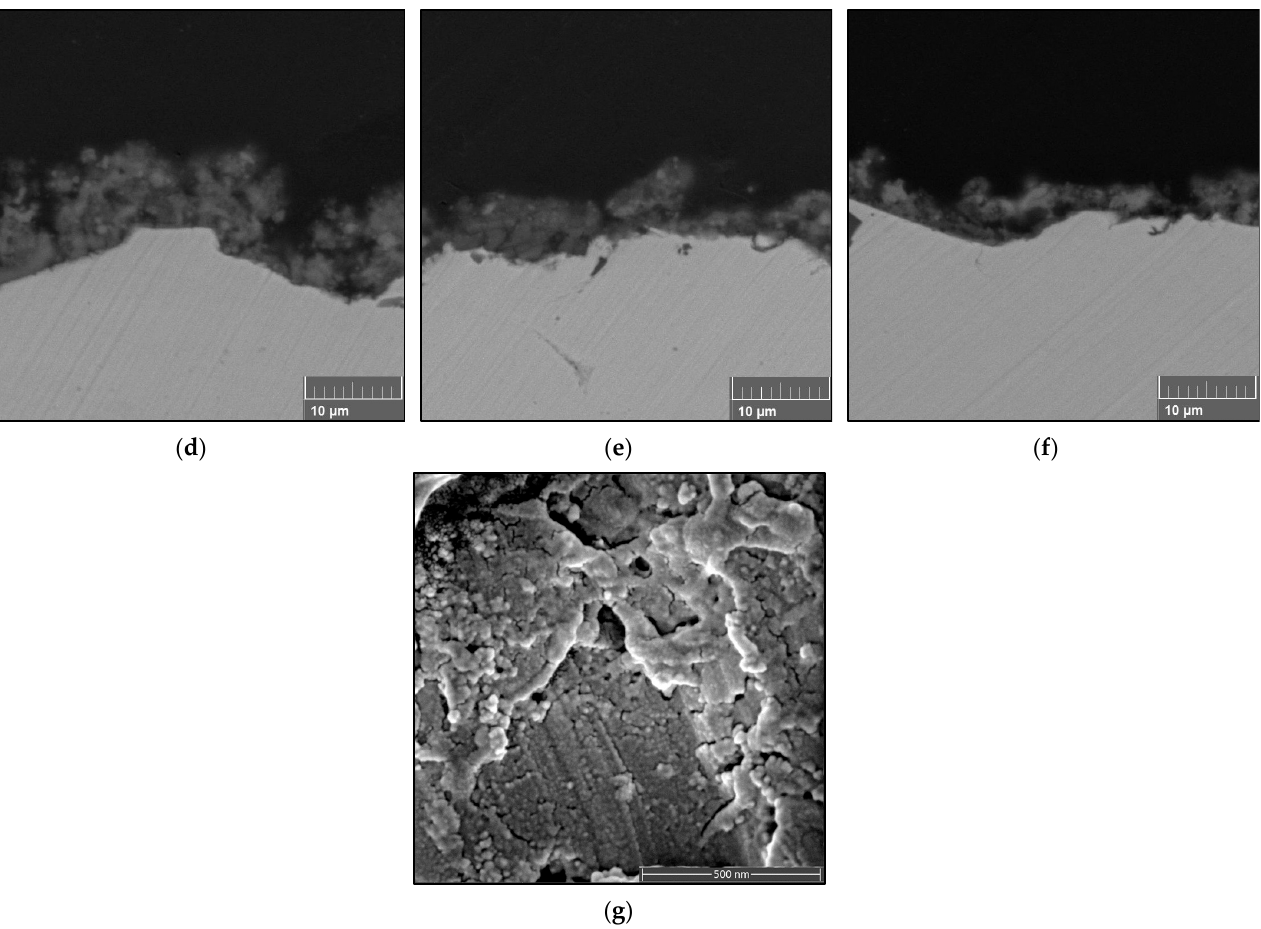
Figure 4. SEM micrographs of the surface of coatings obtained from full-pass sprayed (0.3 M) TiO 2 solution and their cross-sections at ( a , d ) 40 mm, ( b , e ) 50 mm, and ( c , f ) 60 mm stand-off distances. ( g ) The cross-sectional coating structure of FS1SD40 at higher magnification.